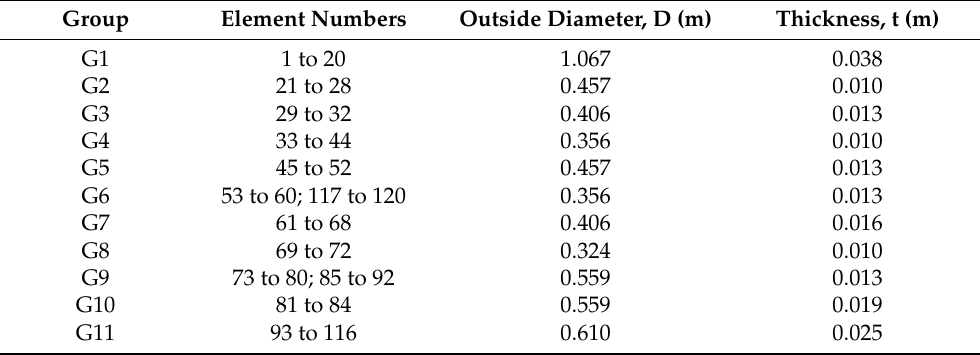
Figure 1. Fixed jacket offshore platform schematic views ( a ) Jacket platform from Azad et al. [40]; ( b ) 3D view of OpenSees model; ( c ) 2D view (elevation); ( d ) Top view; ( e ) Cross section of members. Table 1. Specifications of structural members of the offshore platform [41] .